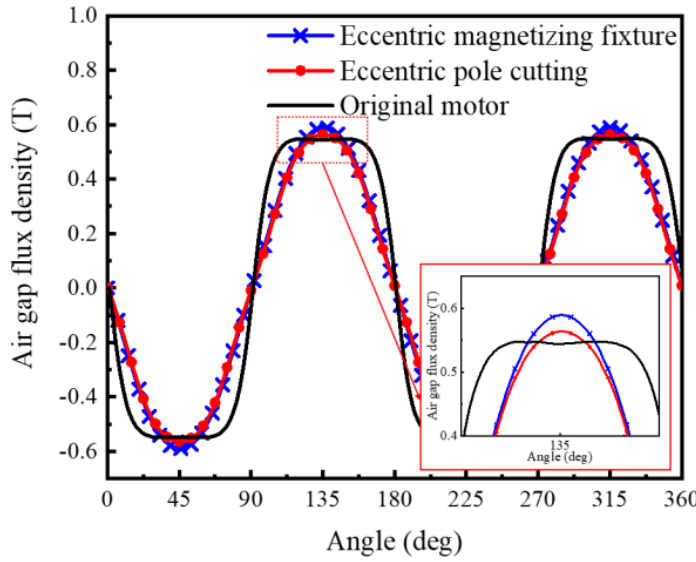
Figure 15. Air − gap magnetic density comparison.